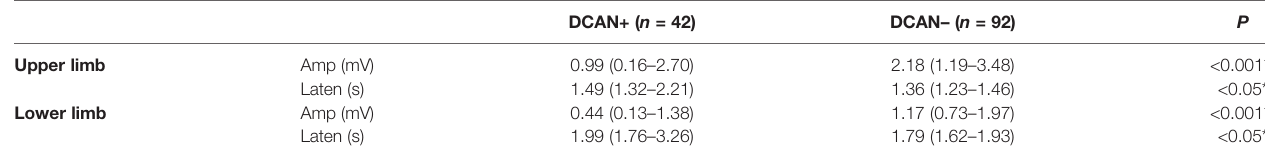
TABLE 4 | SSR of patients with T2DM and DCAN versus those without DCAN.